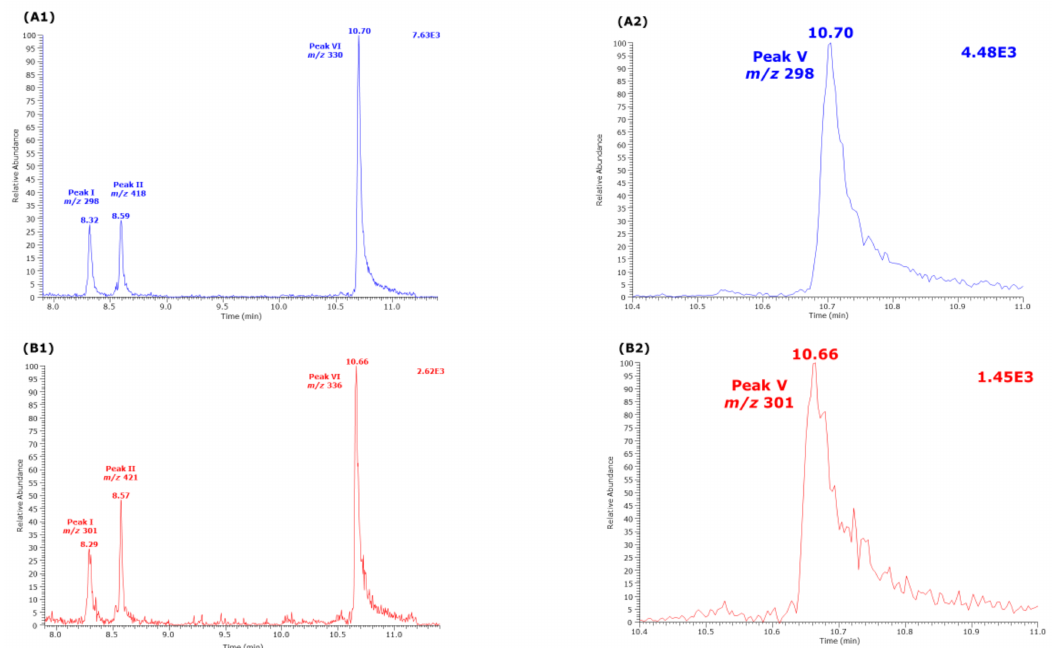
Figure 3. Partial GC-MS chromatograms from the analysis of an aqueous citrulline sample (250 µ M) derivatized by procedure B, i.e., first with PFPA/EA (30 min, 65 ◦ C) followed with 2 M HCl in CH 3 OH or CD 3 OD (60 min, 80 ◦ C). Selected ion monitoring (SIM, 100 ms) of ( A1 , A2 ) m/z 298 and m/z 301 for Peak I, m/z 418 and m/z 421 for Peak II, and m/z 330 and m/z 336 for Peak VI was performed. ( B1 , B2 ) SIM (100 ms) of m/z 298 and m/z 301 for Peak V. See also Table 1 and Figure 2.